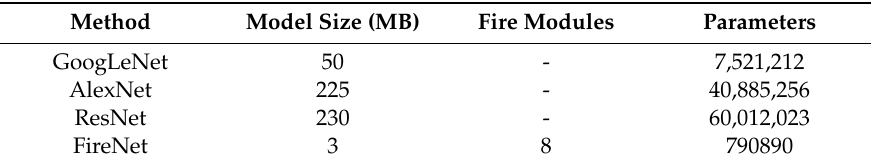
Table 1. Results of the proposed FireNet method and SqueezeNet.